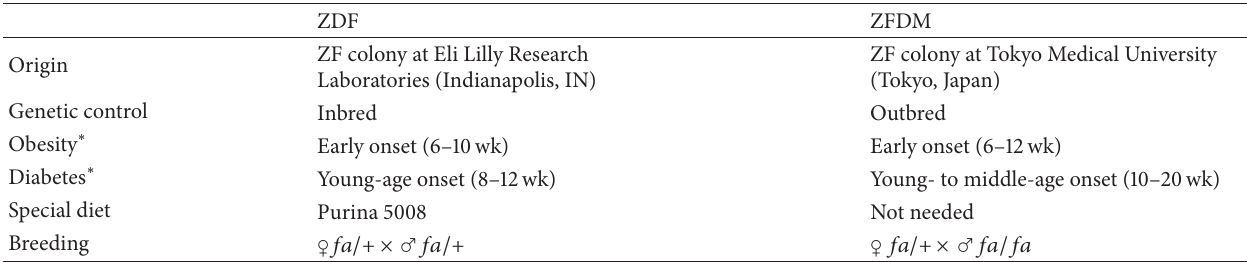
Table 1: Characteristics of the ZDF and ZFDM